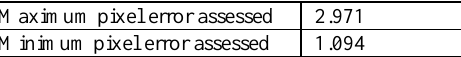
Table 2. Minimum and maximum root mean square error for X, Y coordinates on an image for a GCP location